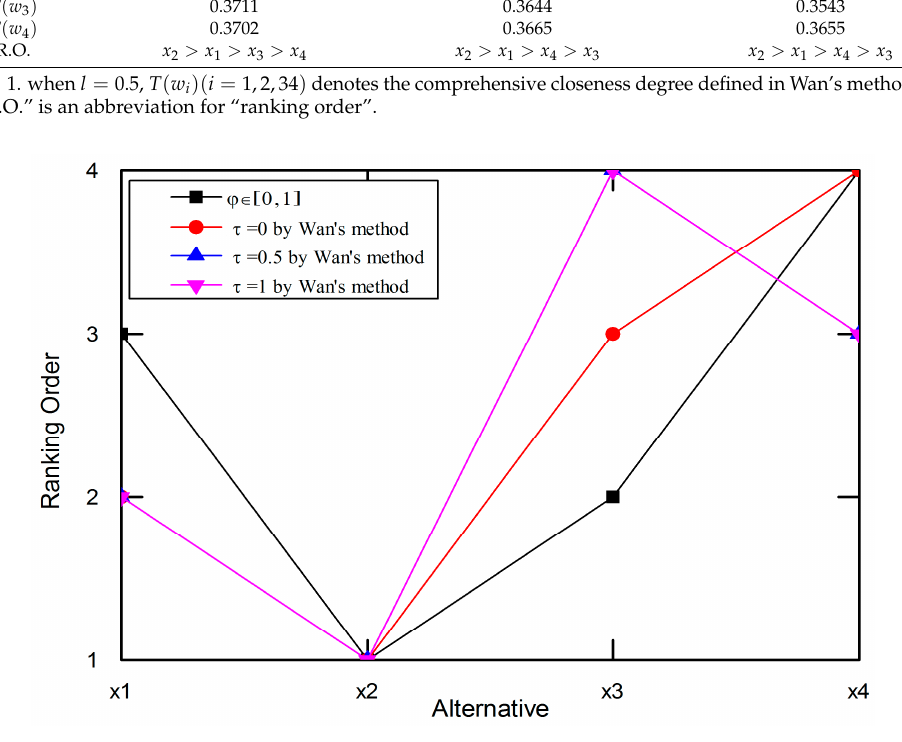
Table 3. Computation results for different DMs’ weights 𝜂 (cid:3036) (𝑖 = 1,2,3) by Wan’s method [ 12 ].